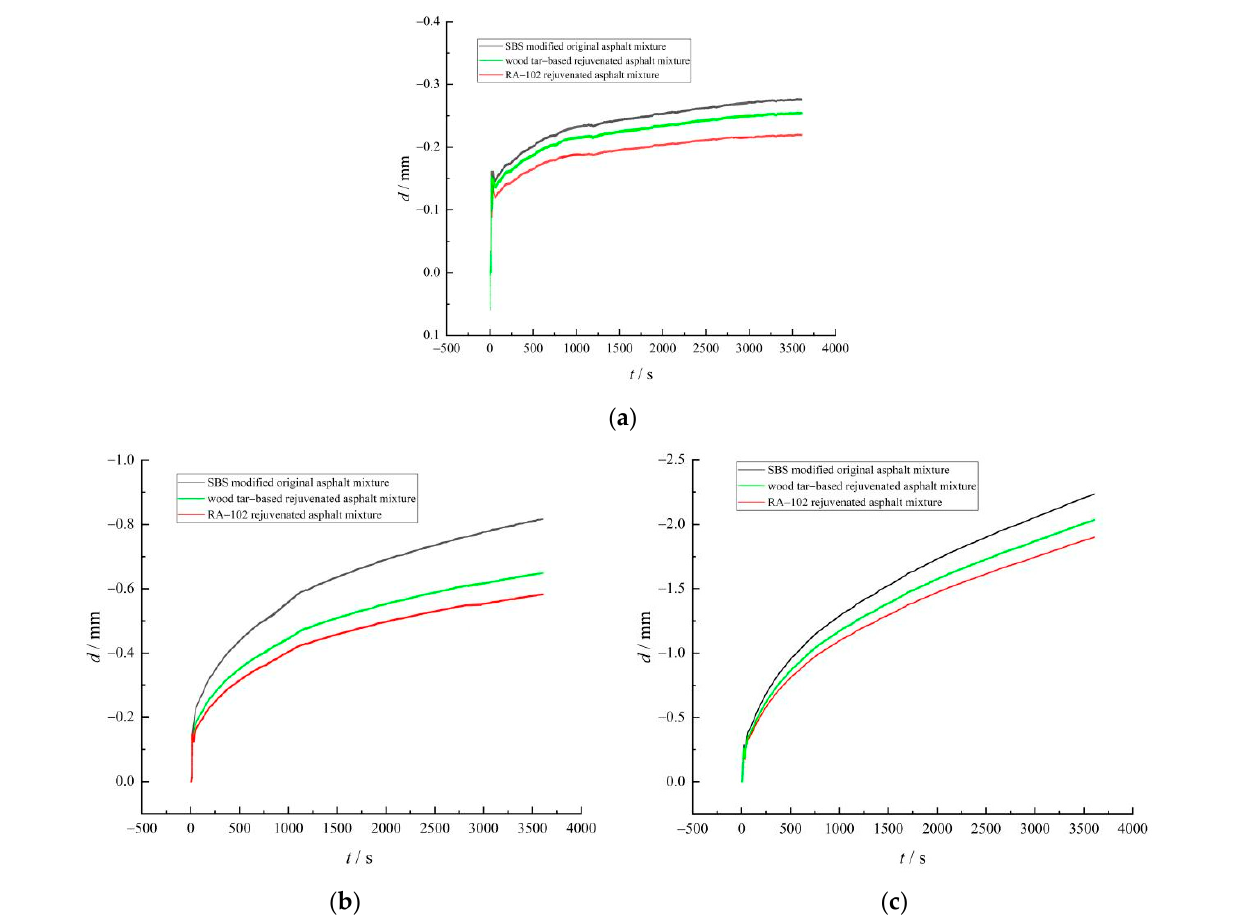
Figure 9. Creep curves of each asphalt mixture. ( a ) Creep curve at − 10 °C, ( b ) creep curve at 0 °C. and ( c ) creep curve at 10 °C.